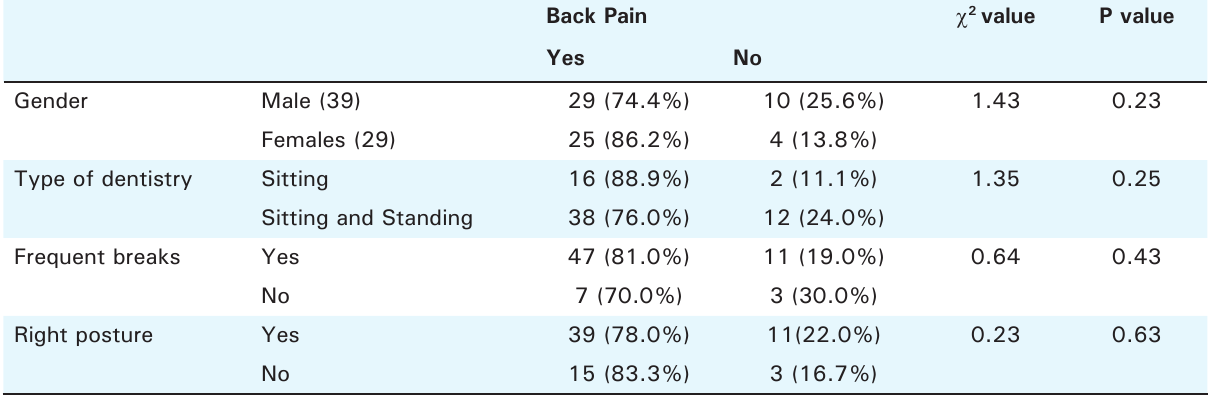
table 4. duration of symptoms in relation to gender sex Male Female total